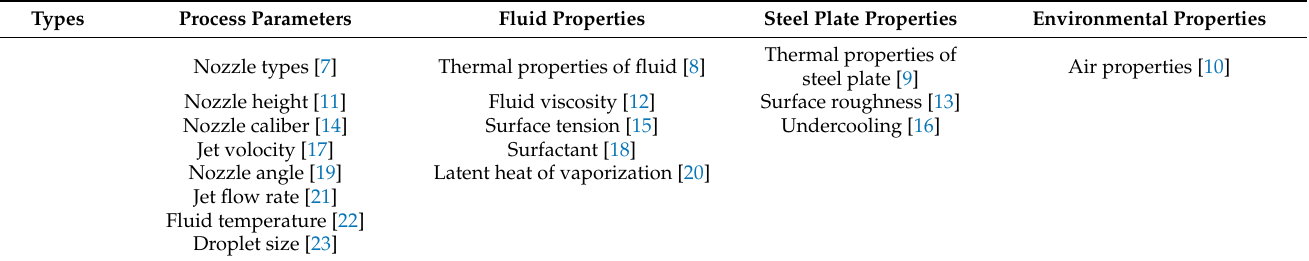
Table 1. Factors that influence the laminar cooling